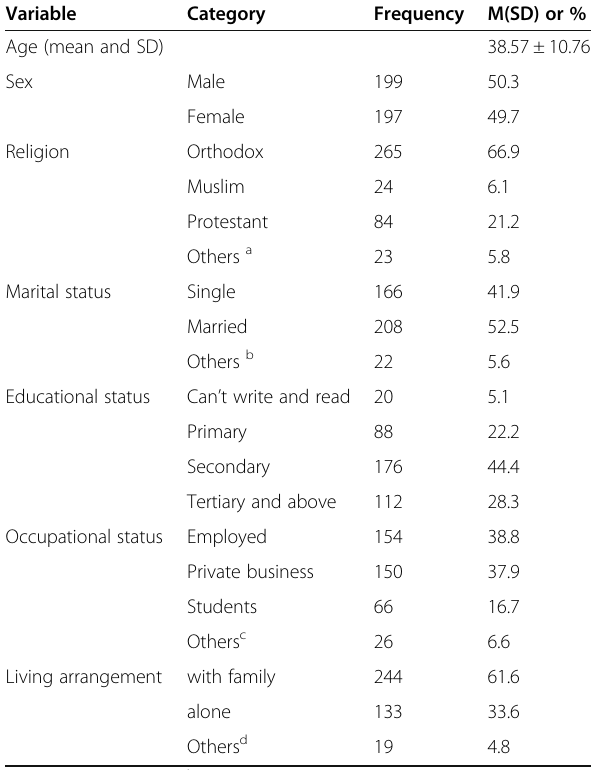
Table 1 Socio demographic characteristics of people living with HIV/AIDS on follow-up at Zewditu Memorial Hospital, Ethiopia, 2018. (n =